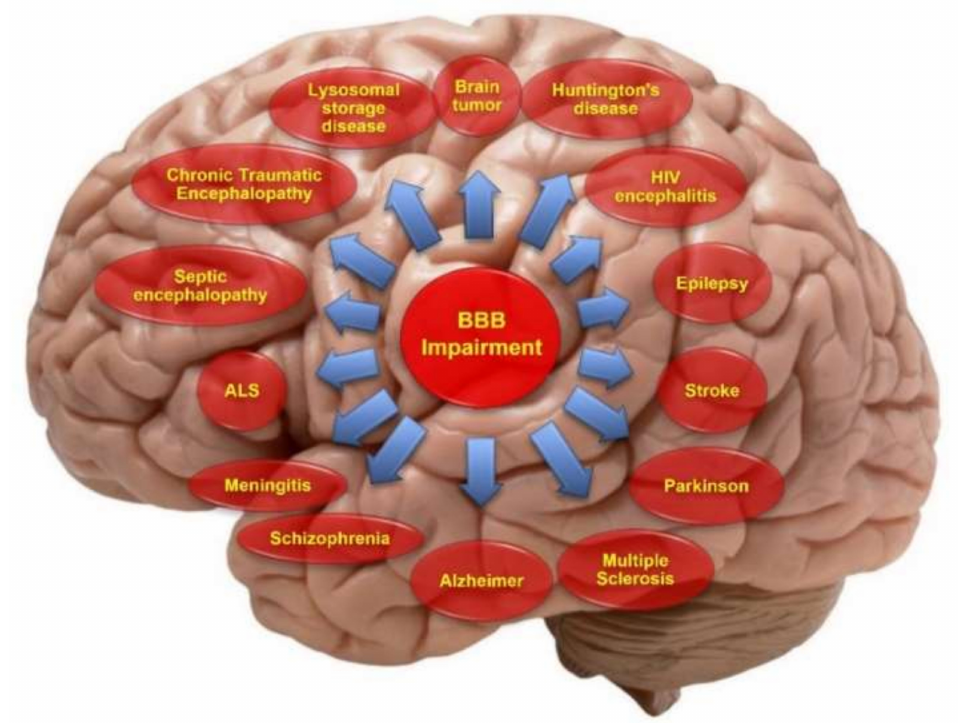
Figure 2. Schematic illustration summarizing some of the major neurological disorders associated with impairment of the BBB. Reprinted from Ref. [25], MDPI,